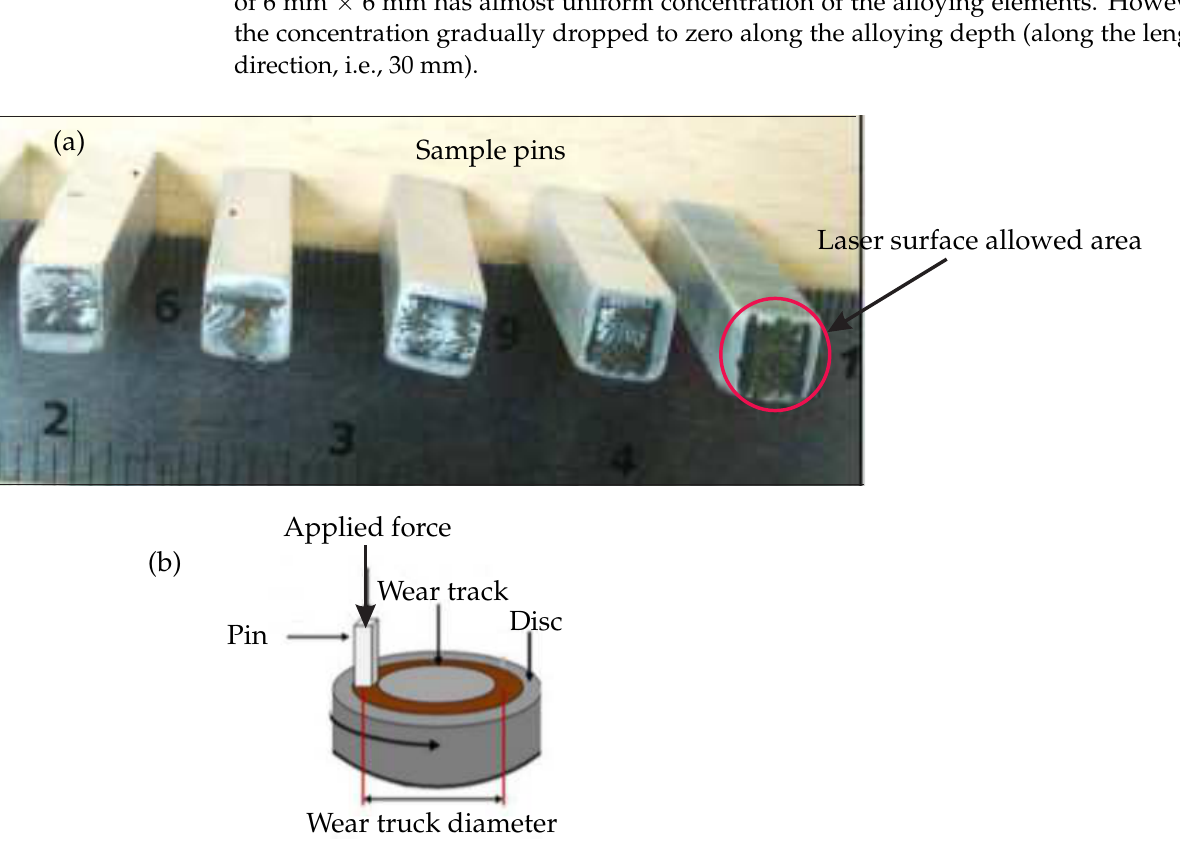
Figure 2. Photograph of laser-surface-alloyed sample and pin used for the tribology test. ( a ) Pin samples prepared for wear testing, ( b ) schematic diagram of the pin-on-disk